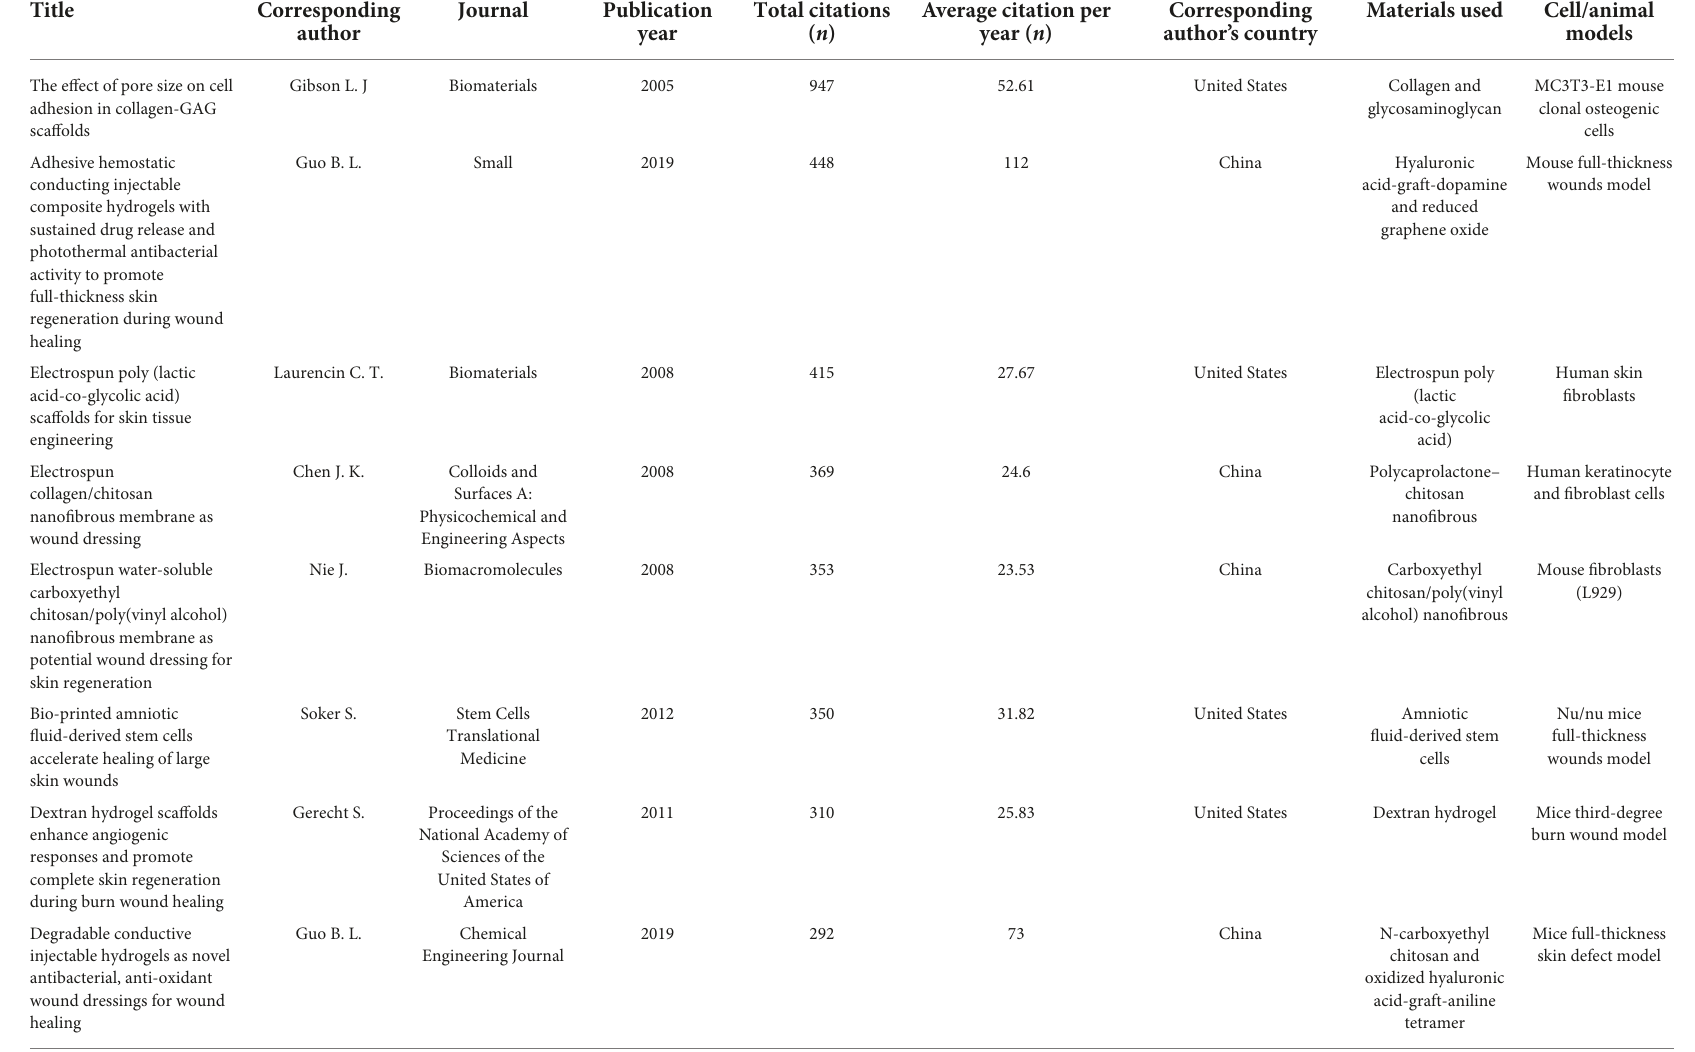
TABLE 1 Top eight most frequently cited articles related to skin